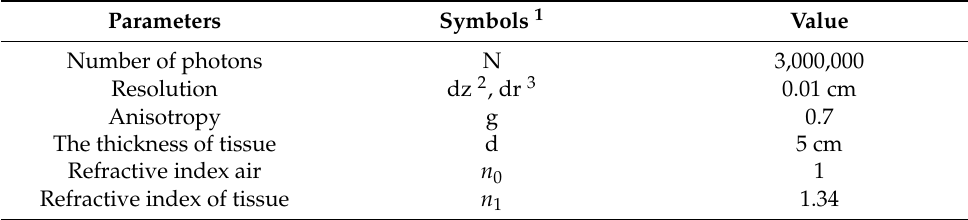
Table 1. Parameter settings for the Monte Carlo